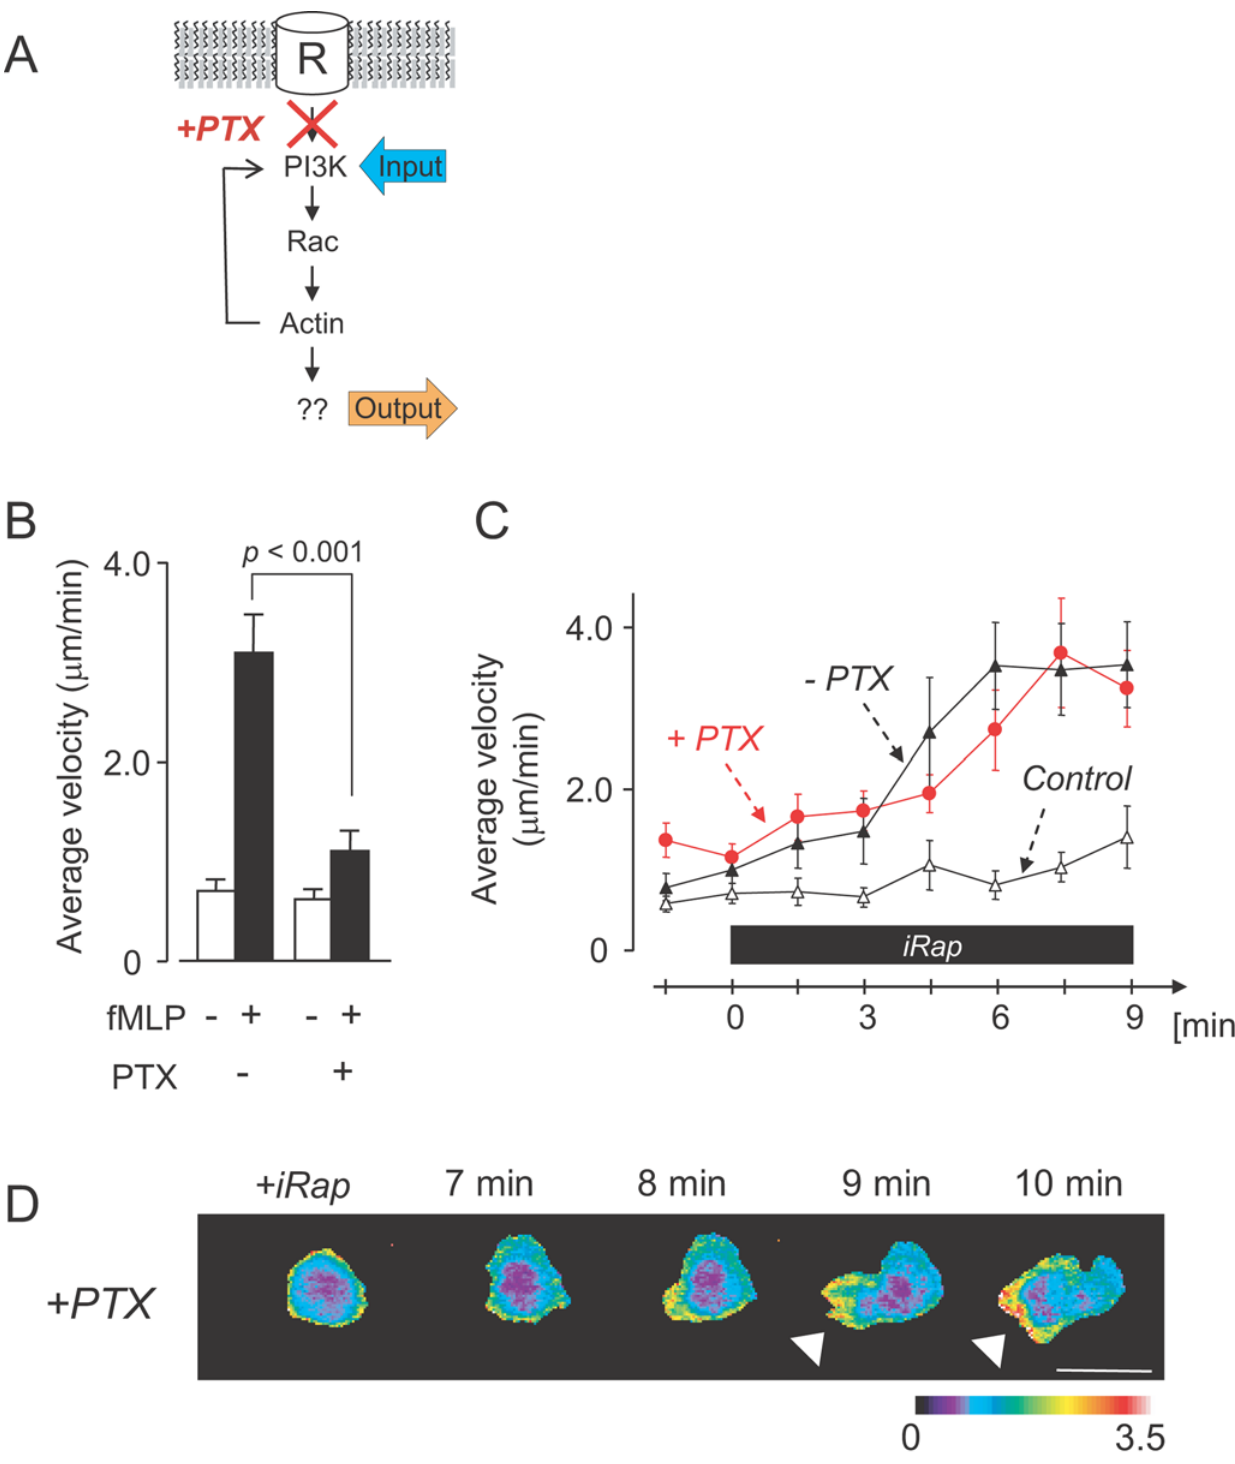
Figure 4. G-protein signaling is not required for PI3K-triggered cell polarization. (A) Schematic representation of experiments conducted in (B)–(D). (B) Control experiment showing that PTX suppresses fMLP-triggered cell migration. Differentiated HL-60 were stimulated with fMLP in the absence or presence of PTX. Average velocities are shown before and after fMLP addition (mean 6 S.E.M.; p , 0.001, n=16 from two independent experiments). (C) Comparison of the kinetics of the velocity increase following synthetic PI3K-activation in the presence or absence of PTX. Cells were transfected with the synthetic PI3K activation system and endogenous PI3K activated by iRap addition. Time axis is after iRap addition. PI3K-induced cell migration velocities increases are statistically indistinguishable in the presence (red circles) or absence (black triangles) of PTX, arguing that G- proteins do not contribute to the PI3K triggered polarity response. (Statistical analysis shows confidence values of 0.16 , p , 0.99; n $ 16 from more than four independent experiments each). As a control, untransfected in the same field of view were analyzed. Error bars indicate S.E.M. (D) Time series of YF-iSH/CFP-PH(AKT) ratio image shows PIP 3 accumulation (arrowheads) at the pseudopod of a PTX treated polarized cell. Scale bar, 10 m m.